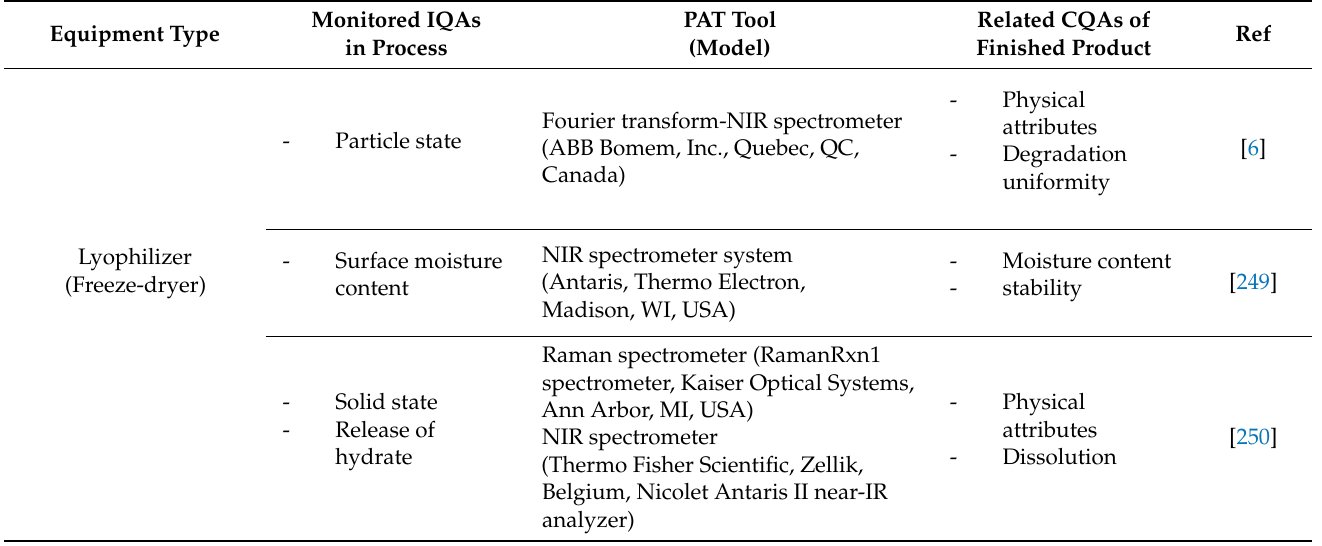
Table 4. Summary of PAT-based modeling method applied in the drying